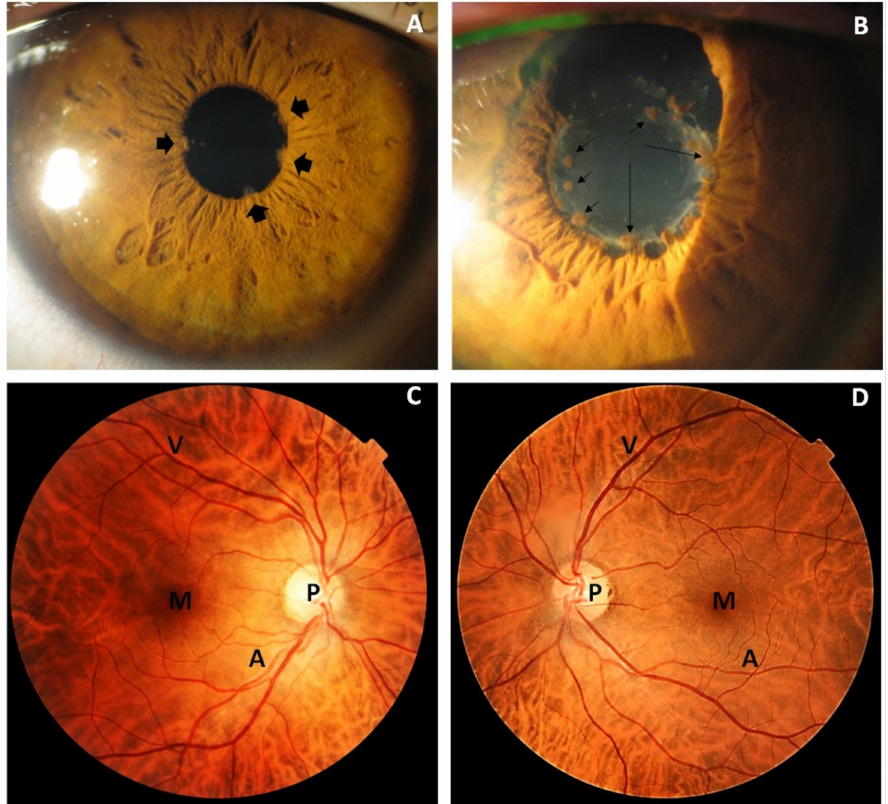
Figure 4. Biomicroscopic photographs (slit-lamp) of the anterior and posterior eye segment from patients with inactive recurrent non-infectious anterior uveitis (NIAU). ( A ) Posterior synechiae (arrowheads) resulted from focal adhesions between the posterior iris and the anterior lens surface. ( B ) Irregularly shaped pupil with posterior synechiae extended over the lens surface, with pupil- lary/prelental membranes (thin arrows) and lens deposits (small arrows). ( C , D ) Normal ocular fundus photographs of the right and left eyes of a 68-year-old patient with recurrent anterior NIAU uveitis in its quiescent stage. T P: optic disc papilla; M: macula; V: retinal vein; A: retinal artery. A deeply pigmented retina gives the appearance of a tessellated non-pathologic fundus (tigroid stripes).